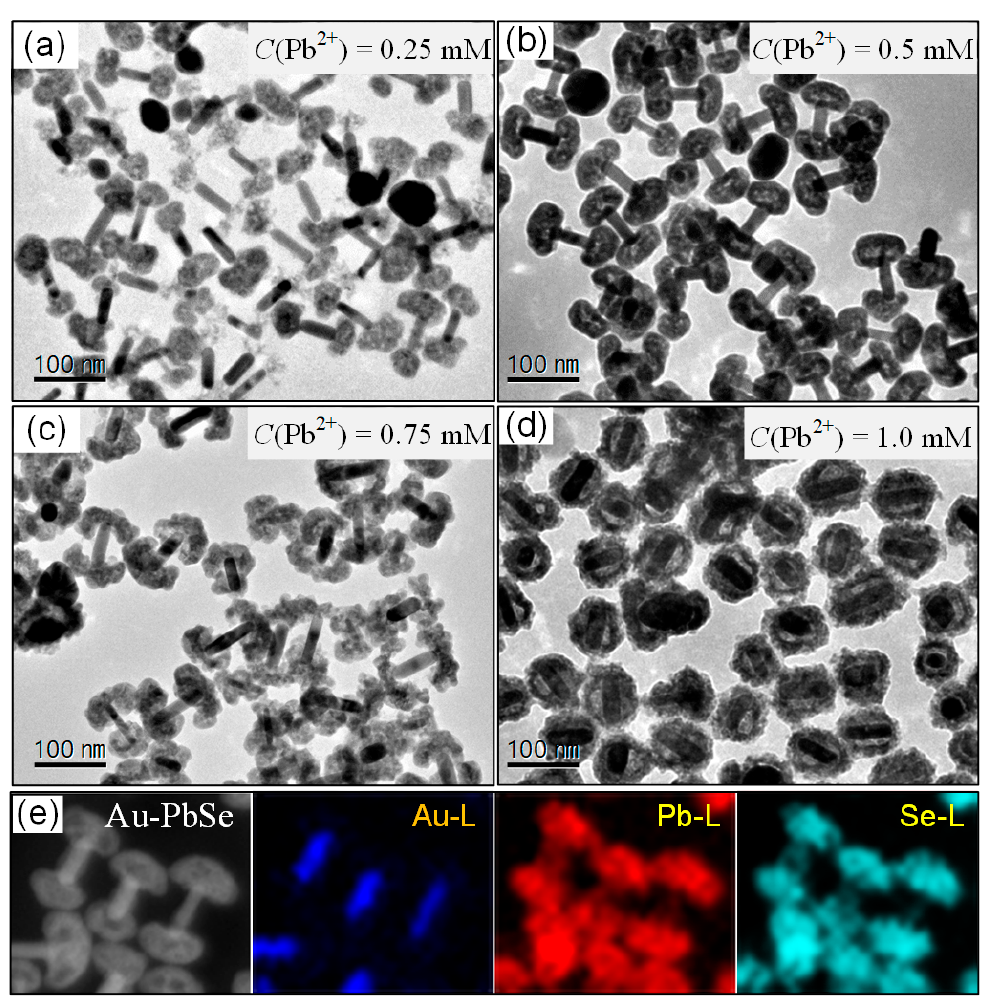
Figure 4. Used Au@Se NRs with 13 nm shells as seeds, the corresponding TEM images of four parallel samples with the initial molar concentration of Pb 2 + ions of ( a ) 0.25 mM; ( b ) 0.50 mM; ( c ) 0.75 mM and ( d ) 1.0 mM, respectively. ( e ) The corresponding HAADF-STEM image and EDS analysis of Au–PbSe nanodumbbells.